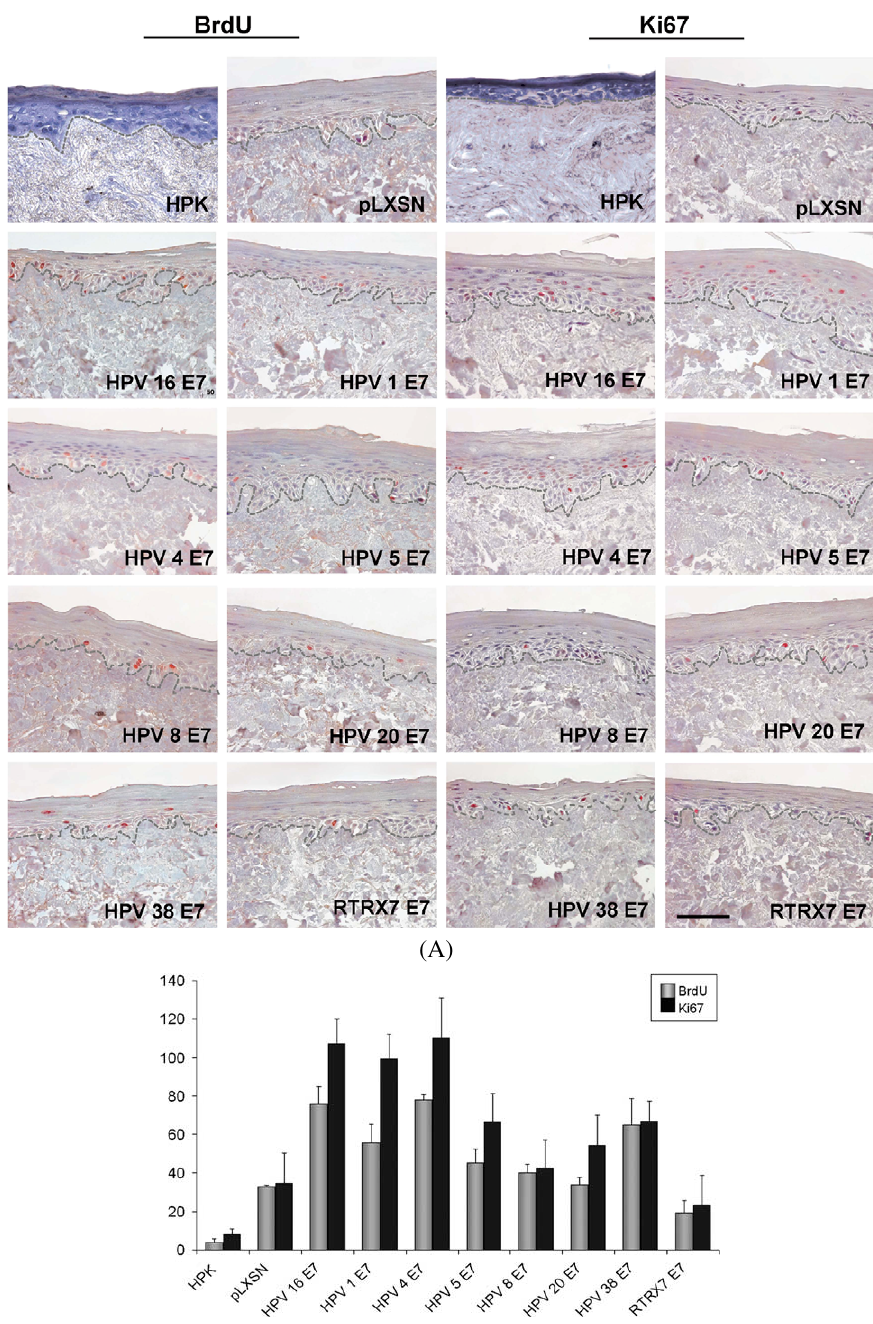
Fig. 4. Increased proliferation in organotypic skin cultures infected with E7 of cutaneous HPV types. (A) The presence of the proliferation markers BrdU and Ki67 was investigated by immunohistochemistry. Representative examples of paraffin embedded sections from organotypic skin cultures are shown with non-infected adult human primary keratinocytes (HPK), or infected with recombinant retroviruses (pLXSN, or E7 of HPV types 1, 4, 5, 8, 16, 20, 38 or RTRX7). Original magnification was × 200. Scale bar: 100 µm. (B) BrdU and Ki67 positive cells in the epidermis are given as mean ± SD within 1 cm 2 of four independent experiments ( y -axis). The numbers of BrdU or Ki67 positive keratinocytes were determined within 1 cm 2 of the epidermis of each section. The highest proliferation rates indicated by BrdU or Ki67 positive cells was observed with HPV types 1, 4, 16 and 38, and lower rates with HPV types 5, 8 and